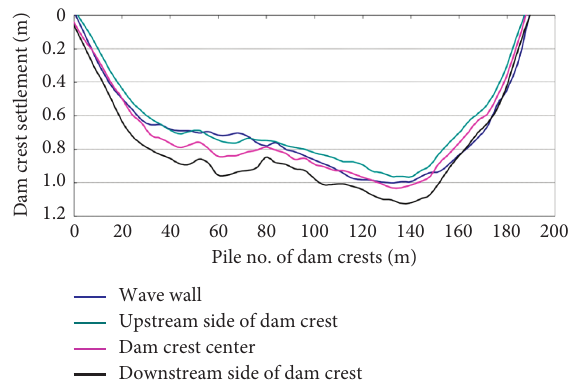
Figure 2: Measured settlement distribution of dam crest pavement and wave wall